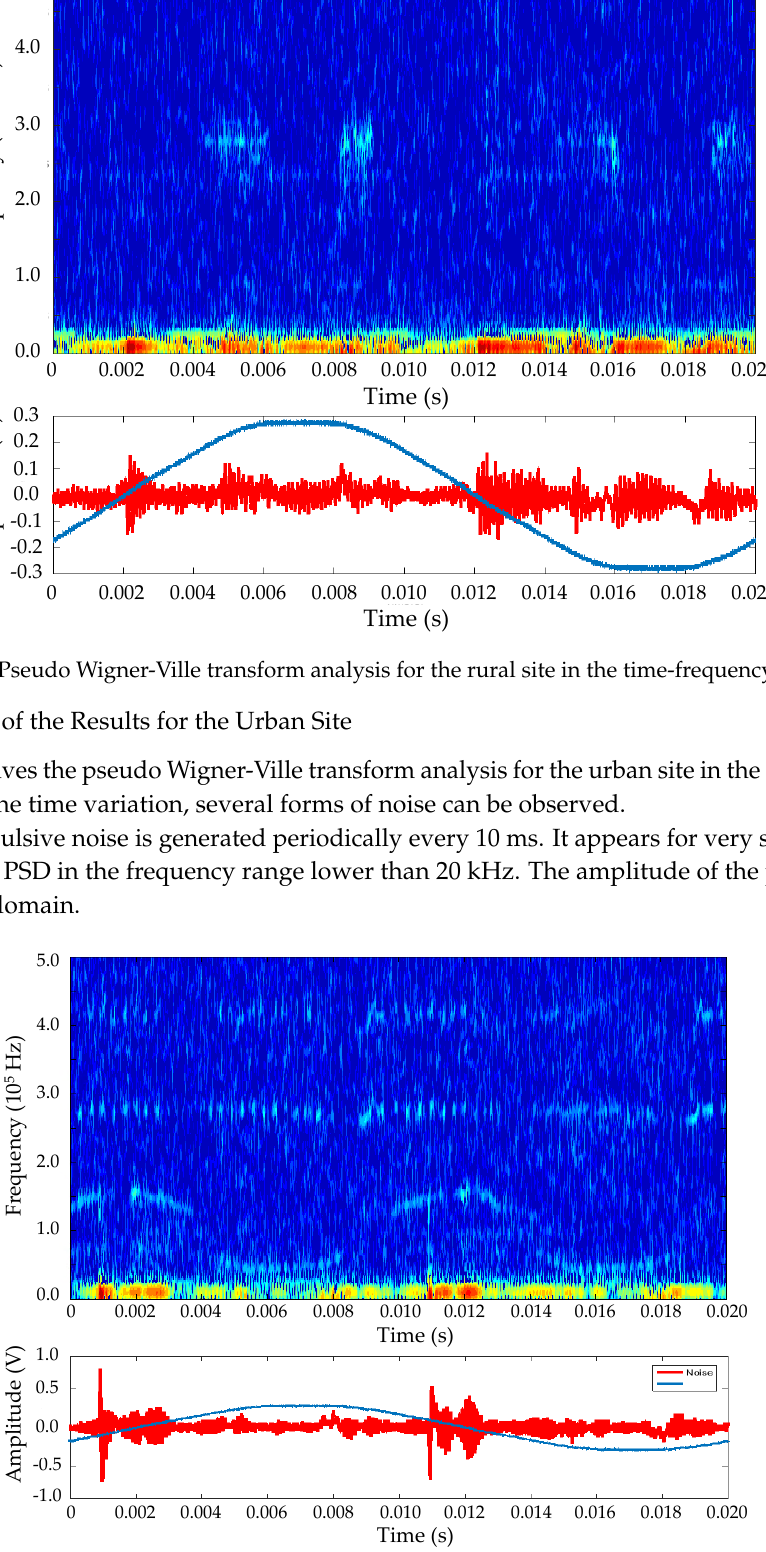
Figure 14 . Pseudo Wigner-Ville transform analysis for the urban site in the time-frequency domain.